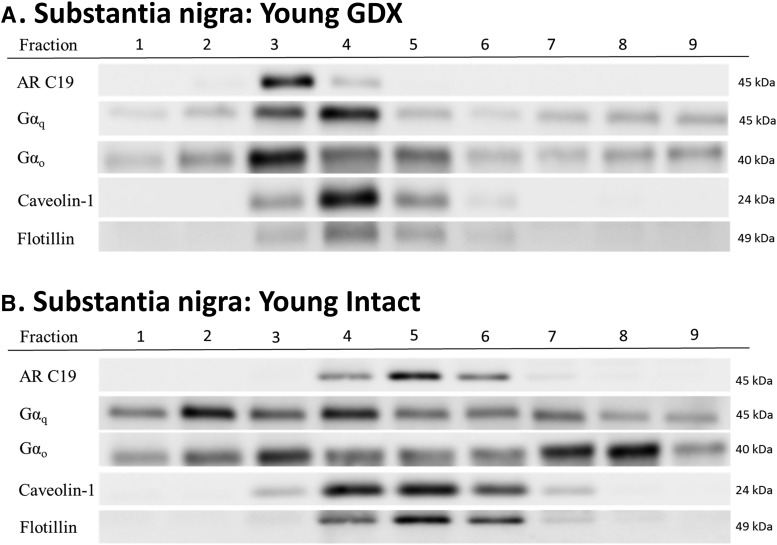
Young male rats express AR45 protein in membrane lipid rafts. Young rats (3 mo old) were either gonadectomized (A) or gonadally intact (B). Micropunches of substantia nigra tissue were collected, and the membrane was isolated and then separated into nine fractions using a sucrose gradient to examine lipid rafts. Primary antibodies targeting AR45 (AR-C19 antibody), G proteins Gαq and Gαo, and lipid raft markers (caveolin-1 and flotillin) were used. AR45 expression was observed only in lipid raft fractions, as evidenced by caveolin-1 and flotillin expression. Hormone status did not alter AR45 expression in lipid rafts. Gαq and Gαo was observed throughout the membrane, regardless of hormone status. No protein expression of Gαi1-3 and Gαs G proteins or full-length (100-kDa) AR was observed in the substantia nigral membranes of young male rats (data not shown). GDX, gonadectomy; intact, gonadally intact. n = 3 per treatment group.